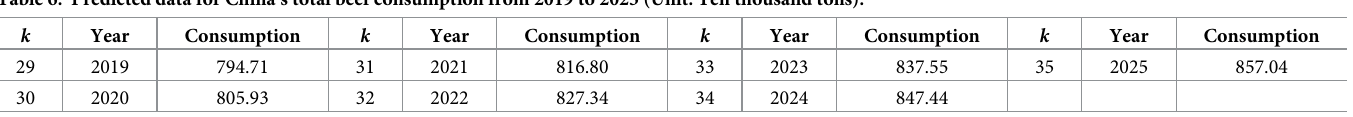
Table 6. Predicted data for China’s total beef consumption from 2019 to 2025 (Unit: Ten thousand